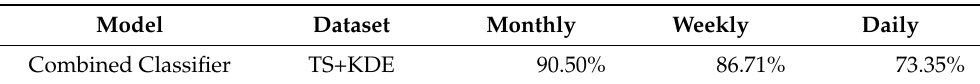
Table 3. Comparison of the classification accuracies of electric vehicle charging of the Combined Classifier for different input periods.